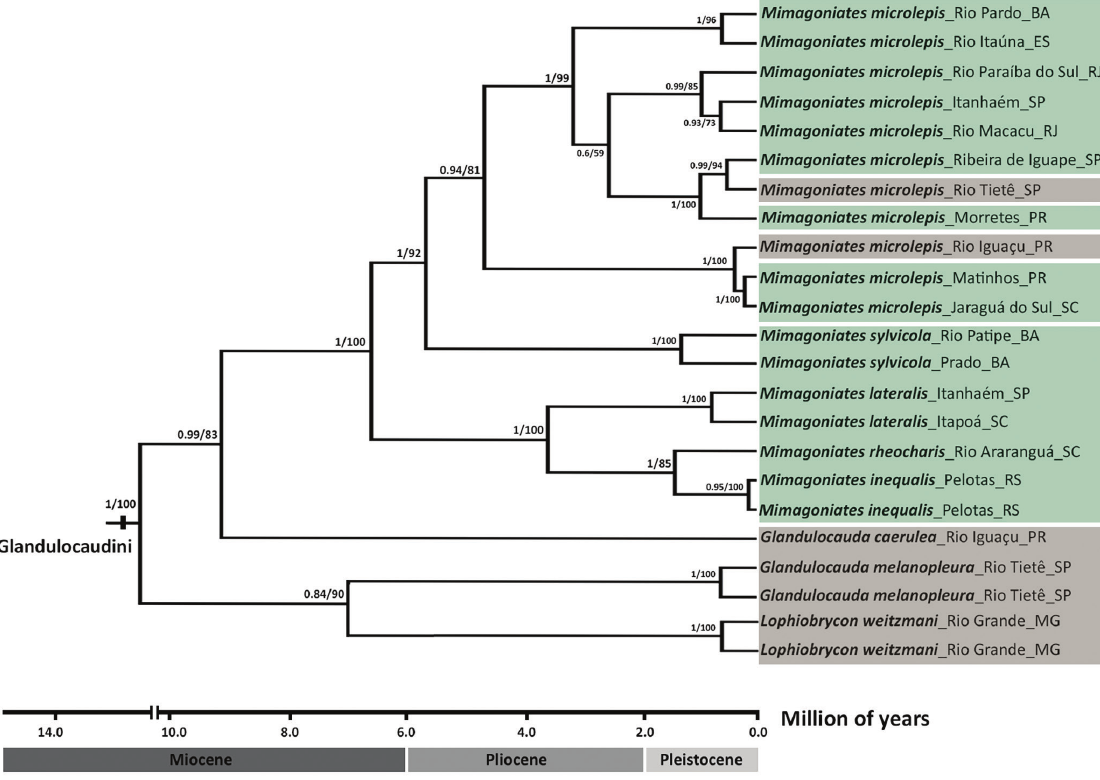
Fig. 2. Calibrated Bayesian tree based on concatenated dataset (16S+COI+RAG2, 1,829 bp) showing the relationships within the Glandulocaudini. Numbers at branches are posterior probabilities and bootstrap values. Species/populations from Brazilian crystalline shield are highlighted in brown (upland areas) and species/populations from Brazilian coastal drainages in green (lowland